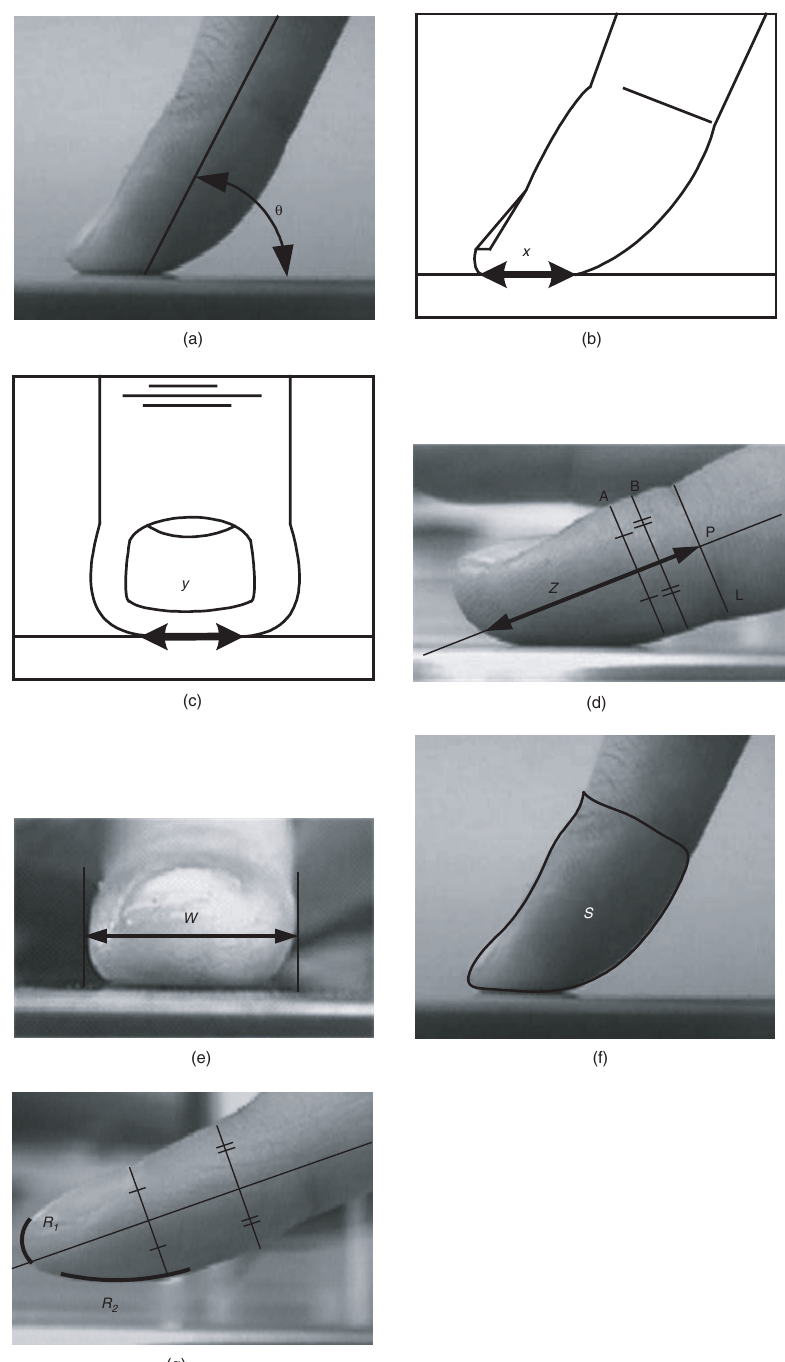
Figure 2 (a) The contact angle of the index finger was formed by the midline of the finger and the surface of the platform. (b) The contact length ( x ): The length by the lateral view of the contact surface between the fingertip and the platform was adopted as the contact length. (c) The contact width ( y ): The width of the contact surface by the frontal view between the fingertip and the platform was adopted as the contact width. (d) The length of the central axis ( z ): By the lateral view of the finger, a vertical line L was drawn from the depression of the bent distal interphalangeal joint to the midline of the fingertip, and the distance between the cross point to the midline (P) and the tip of the midline (Q) was adopted as the length of the central axis. (e) The maximum width ( w ): The width of the fingertip by the frontal view was measured as the maximum width. (f) The lateral-view area ( S ): The area between the fingertip and the line L by the lateral view of the fingertip was measured as the lateral-view area. (g) The radius of the curved surface from the cross point between the central axis of the fingertip and the surface of the finger tip to the tip of the nail was calculated as the curvature radius of the fingertip. Similarly, the curvature radius at the fingertip contacting the ceiling plate was measured and employed as the curvature radius of the contact area. 275 C (cid:1) Woodhead Publishing Ltd